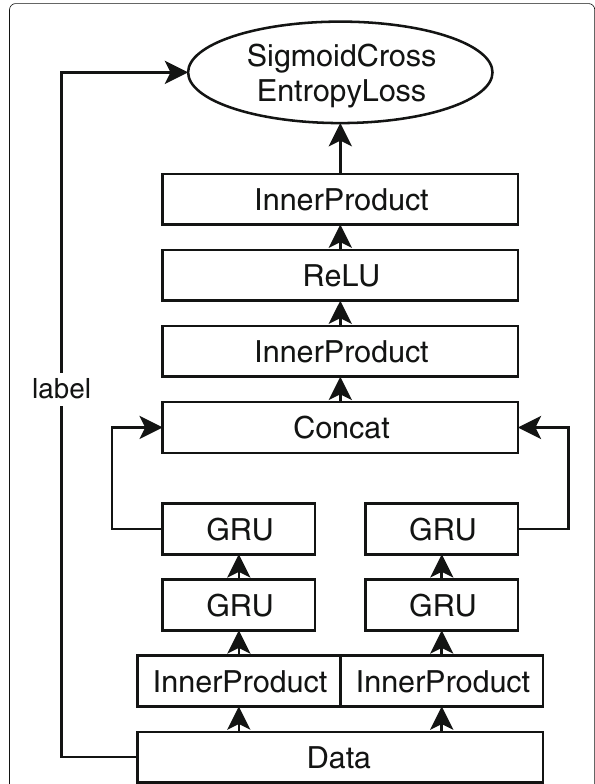
Fig. 16 Structure of the recurrent network used in AMT experiments. The inputs are 16 time steps before and after current label. The number of hidden state of GRUs is 200, the output numbers of InnerProducts are all 200 except the last one is 88. Before concatenation, we only keep the last step’s output of each GRU because they accumulate all the information through time. Legends can be referred to Fig.